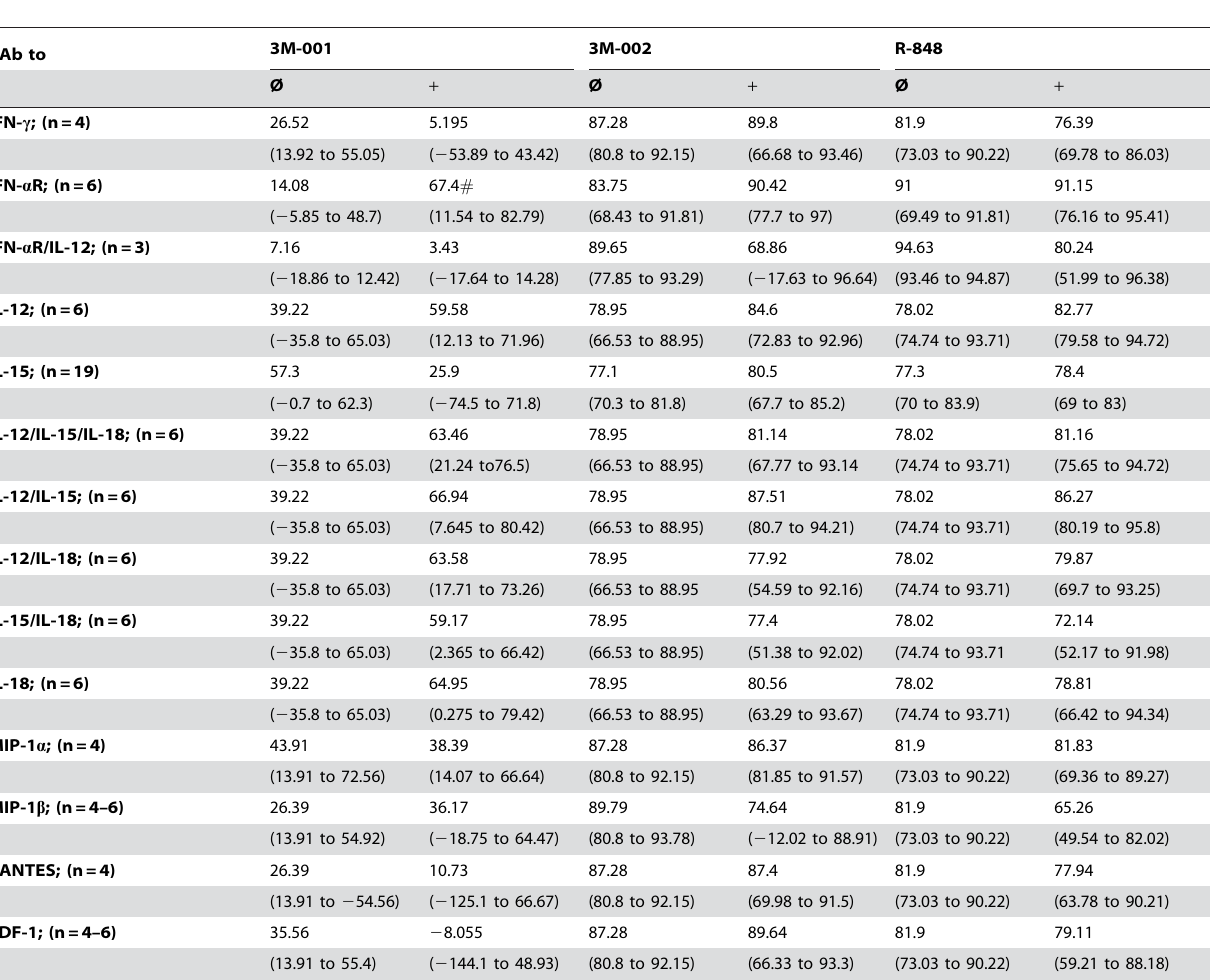
Table 5. Neutralization of cytokines had no impact on anti-HIV activity subsequent to triggering TLR8 and/or 7/8; indicated are the percent inhibition of anti-HIV activity (median (25 to 75%